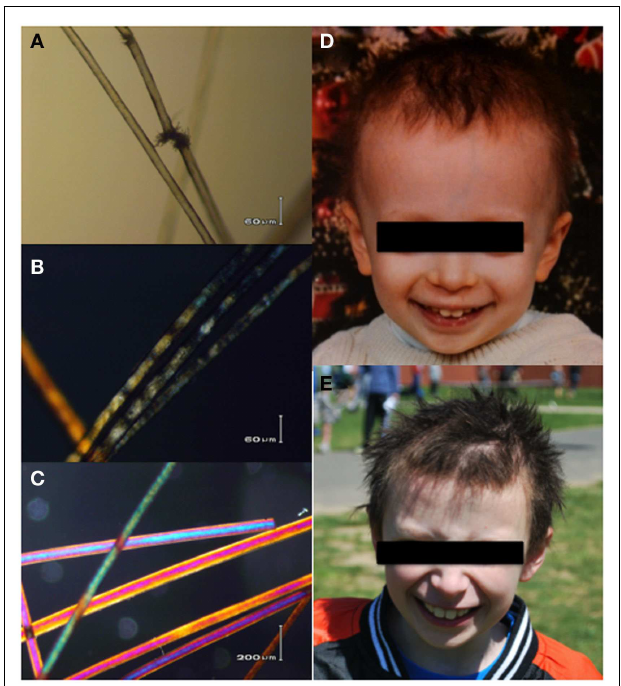
FIGURE 1 |The patients hair shafts have trichorrhexis nodosa-like defects (A), and under polarizing microscopy (B) show a somewhat irregular banding pattern reminiscent of, but distinct from the tiger tail banding characteristic of trichothiodystrophy .These are not seen in the polarized view of hair shafts from his brother (C) . Pastel colors are artifacts. (D,E) Show the patients facial features and gross hair morphology at ages 2 and 10years, respectively. Hair analysis and photos compliments of Alan Zhou, John J. DiGiovanna, DeborahTamura, and Kenneth H. Kraemer. Patient photos courtesy of the family archive, used with permission.